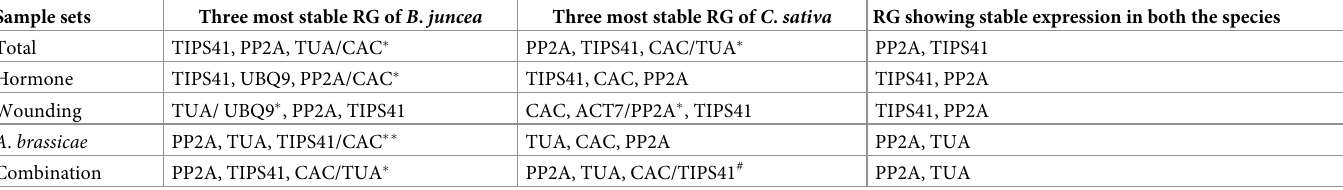
Table 4. Reference genes identified based on results of geNorm, NormFinder and BestKeeper showing stable expression in B . juncea and C . sativa . Sample sets